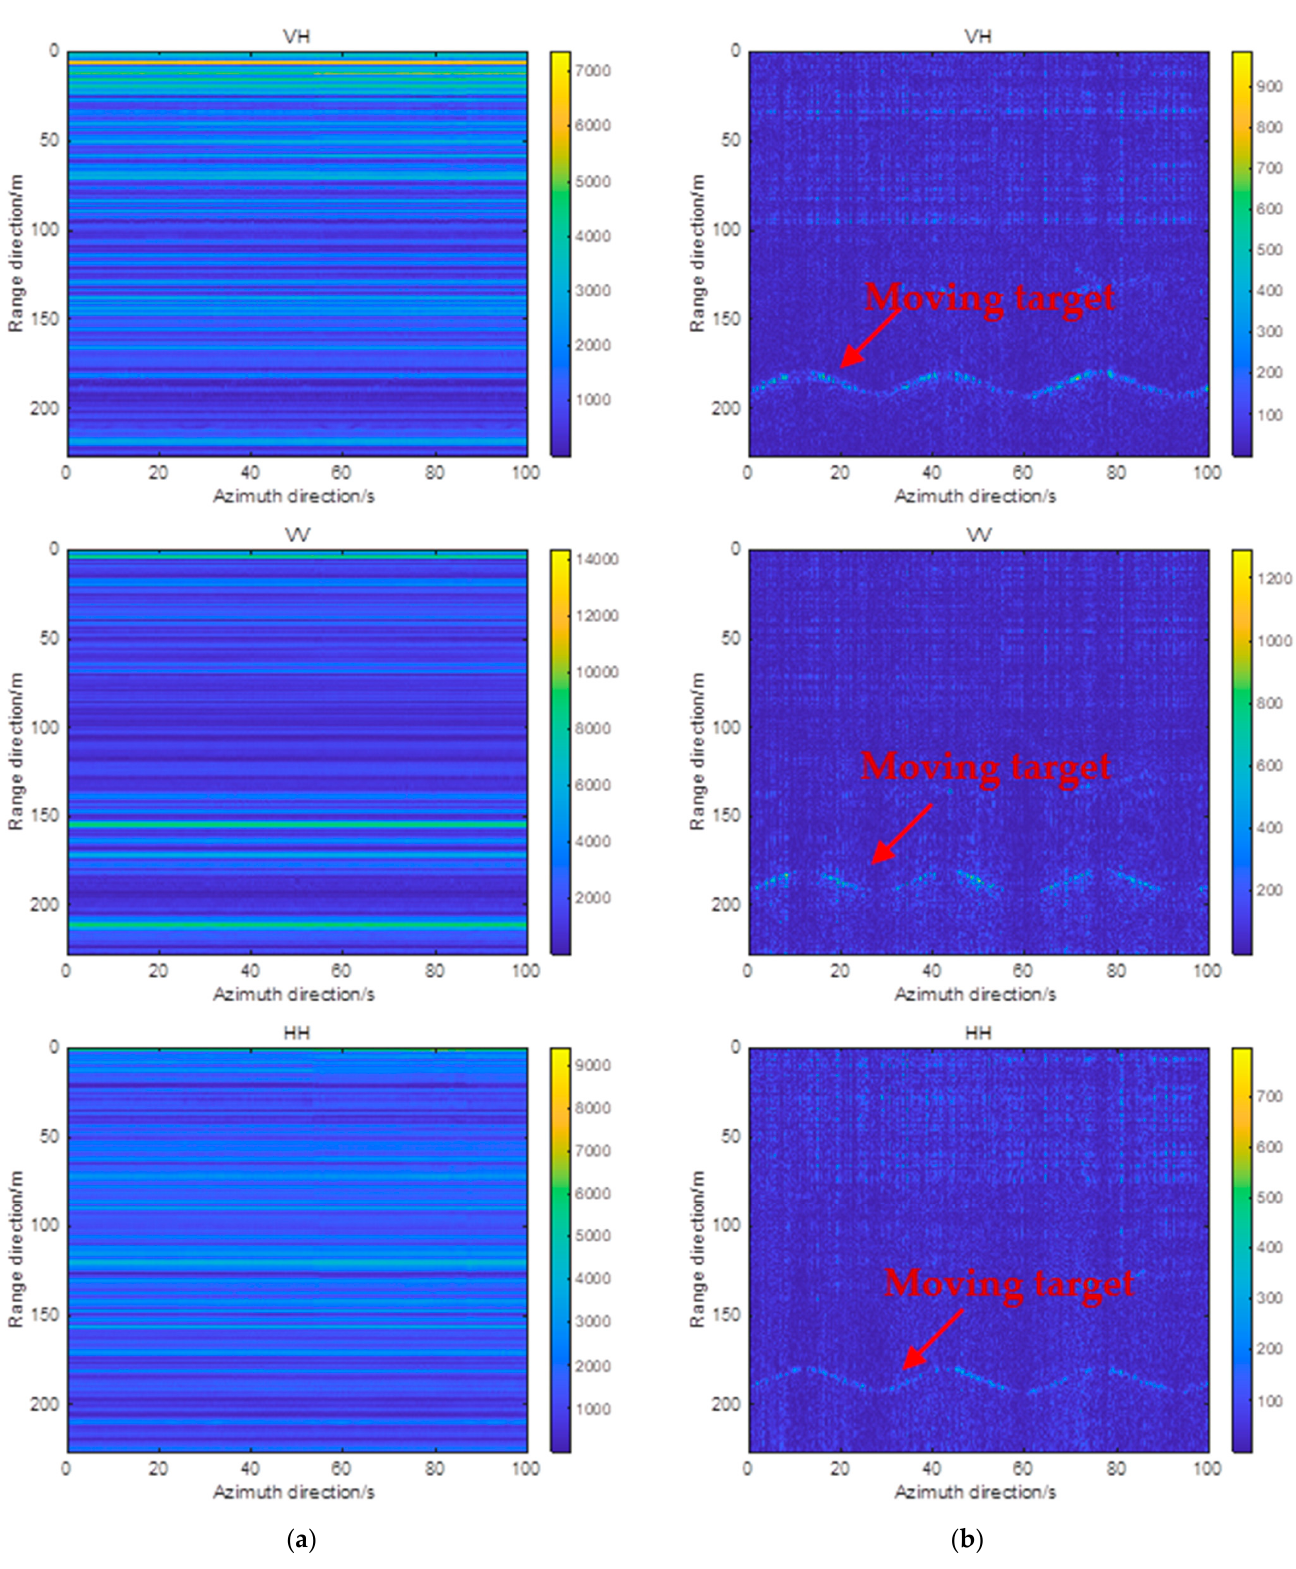
Figure 12. Two-dimensional range image of echo signal. ( a ) Before background removal. ( b ) After background removal.